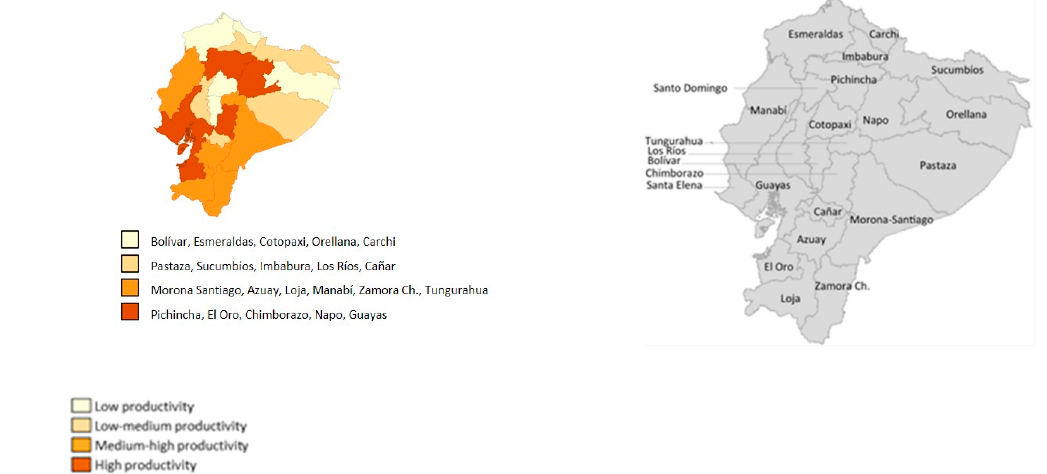
Figure 4. Gini index and standard deviation of provincial productivity in Ecuador, period 2007–2017. Source: Own elaboration based on the Regional Accounts of the BCE [46]; ENEMDU surveys from the INEC [47] (several years) and Distributive Analysis Stata Package (DASP).